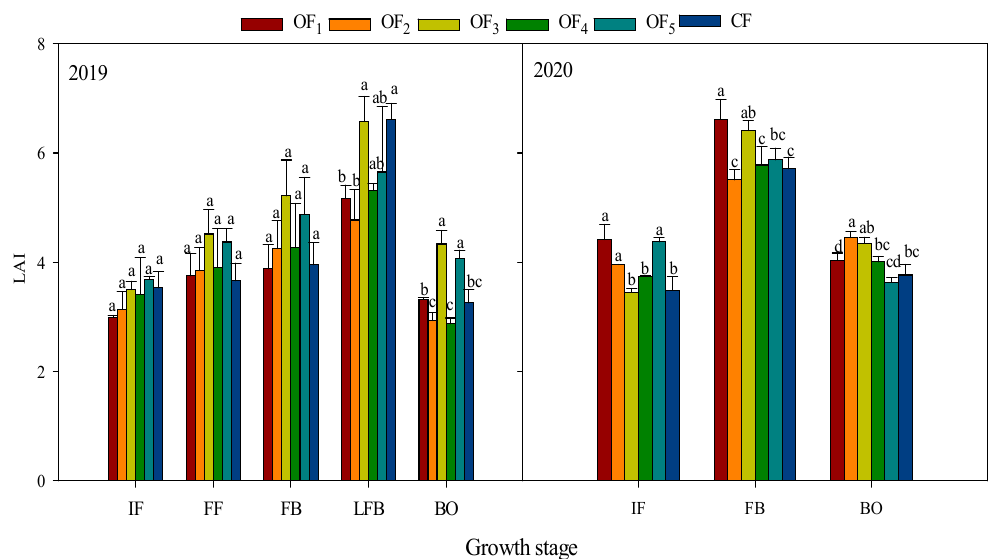
Figure 3. Effect of organic liquid fertilizer combined with different ratios of chemical fertilizers on the cotton leaf area index. IF, initial flowering stage; FF, full-flowering stage; FB, full-boll stage; LFB, late full-boll stage; BO, boll-opening stage. Different letters above the columns indicate statistical significance at the p = 0.05 level within the same growth stage in each year.